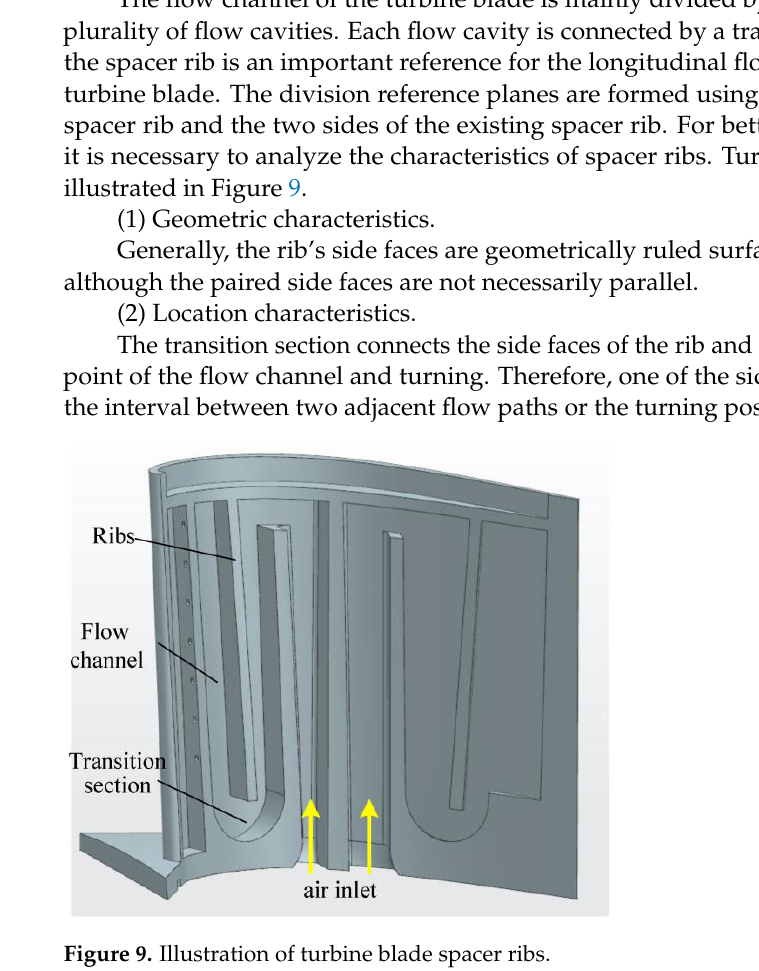
Figure 9. Illustration of turbine blade spacer